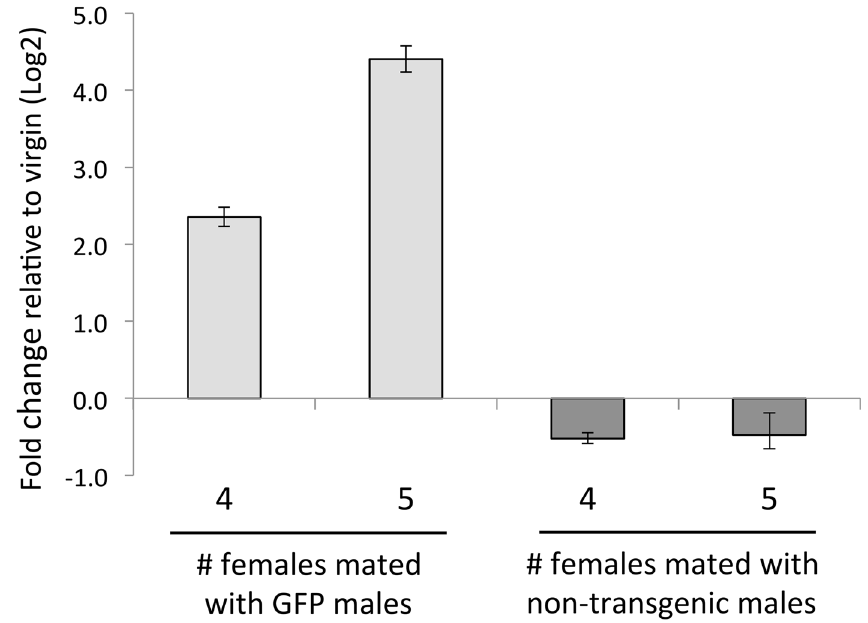
Fig 4. Transfer of eGFP mRNA during mating. GFP mRNA content in wild type females was measure by qRT-PCR. Each sample was obtained from either wild type Thai females (4 or 5 individuals) mated to AAEL010824-GFP transgenic males or wild type Thai females (4 or 5 individuals) mated to non-transgenic males. Relative expression values were calculated by normalizing the expression with RpS17 . This graph represents three technical replicates, with the error bars representing the standard deviation between those three